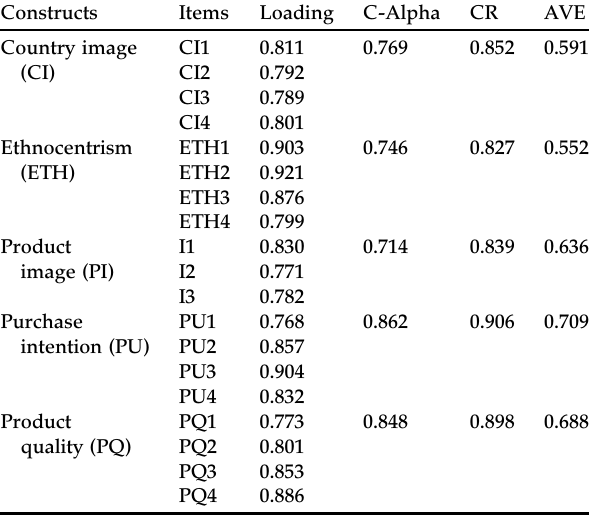
Table 2. Measurement model (factor loading, Cronbach ' s Alpha, CR and AVE).